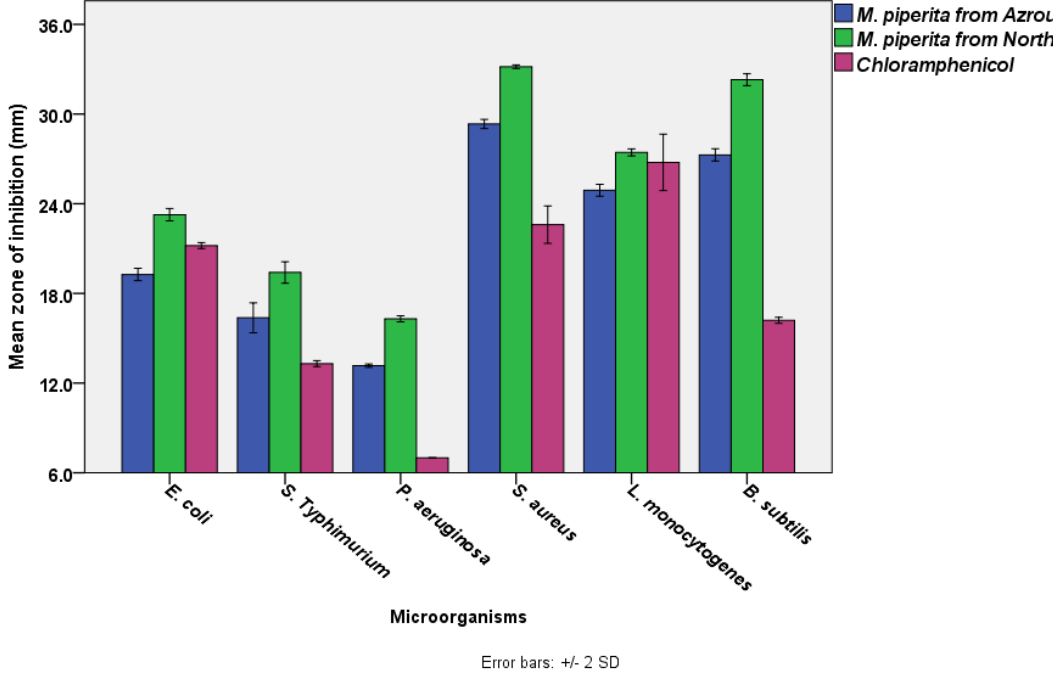
Figure 1. The antimicrobial activities of M. piperita EOs from the Azrou and Ouezzane regions using disc diffusion test (The diameter of the paper disc is 6.0 mm, the concentration of M. piperita from both regions was 100% v / v . The concentration of chloramphenicol was 30 µg /mL).